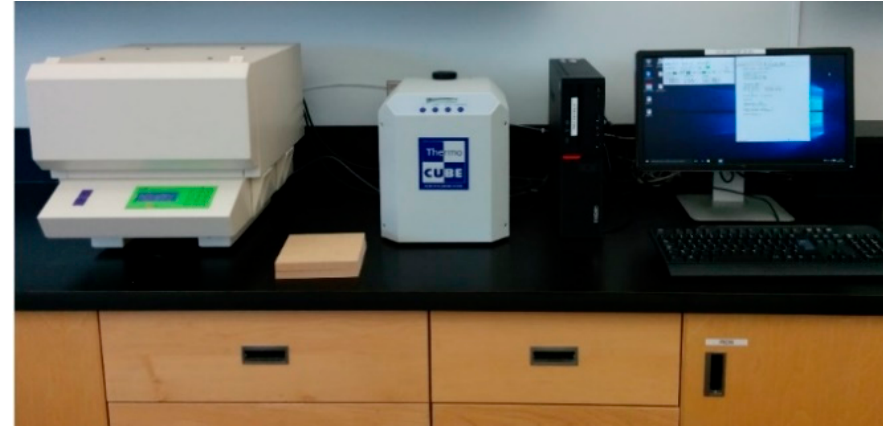
Figure 7. Equipment for thermal conductivity measurements.